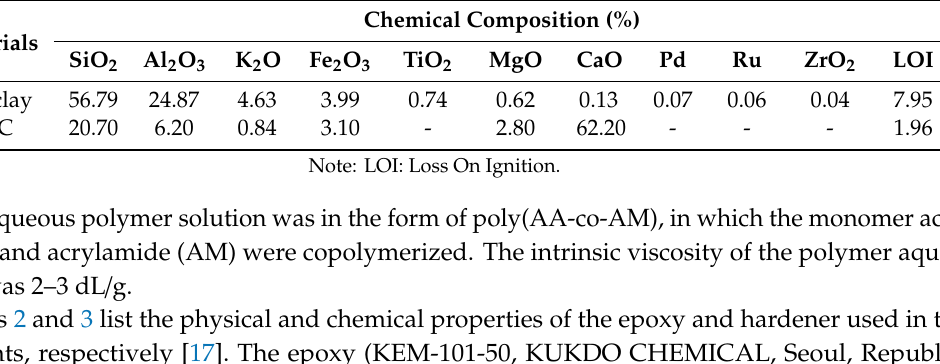
Table 1. Chemical Compositions of Materials Used in the Experiments.